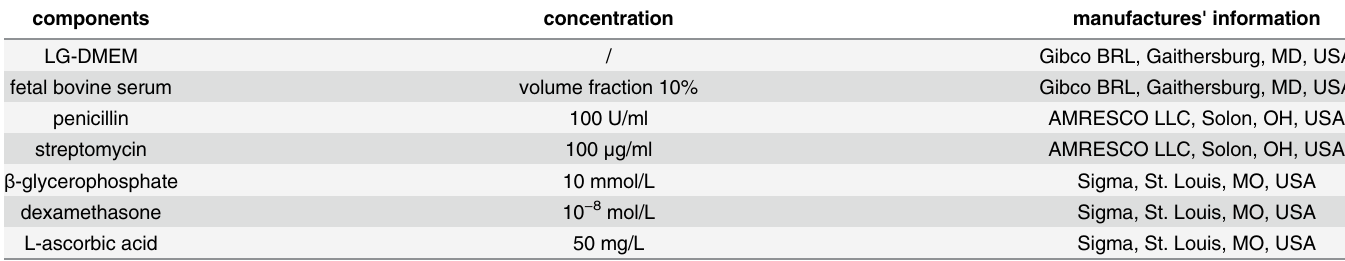
Table 2. The detailed osteogenic medium component